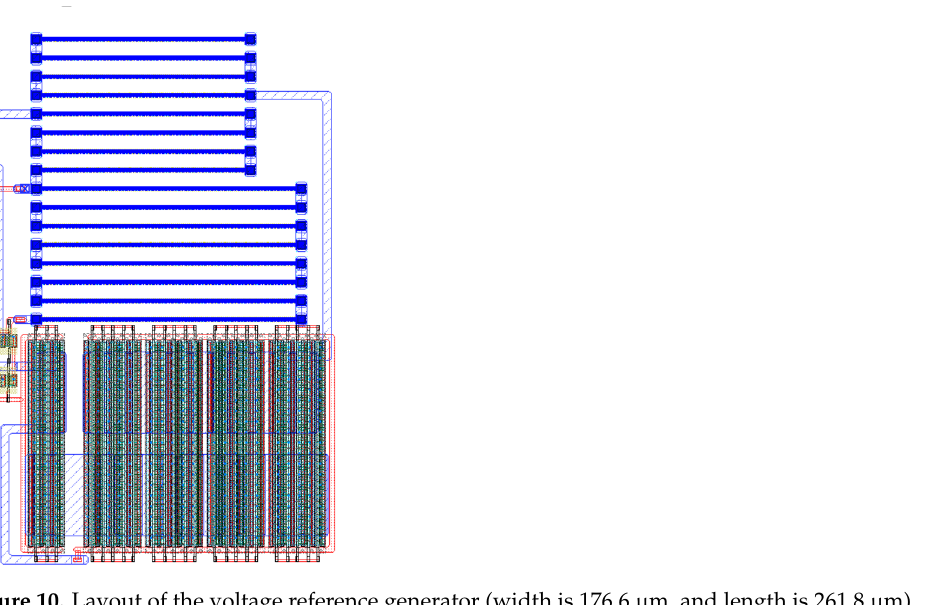
Figure 10. Layout of the voltage reference generator (width is 176.6 µm, and length is 261.8 µm).